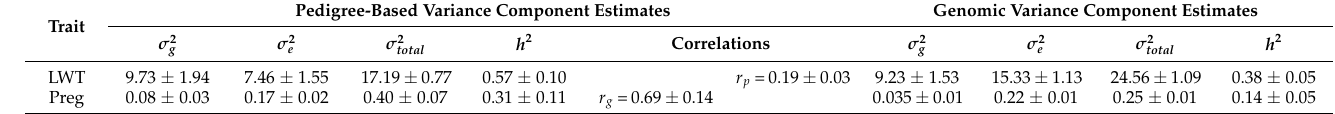
Table 2. Estimates of variance components and heritabilities with their respective standard errors using the pedigree-based additive genetic relationship matrix and genomic relationship matrix for ewe lamb live weight (LWT) or the occurrence of pregnancy (Preg) when bred for the first time, at eight months of age.